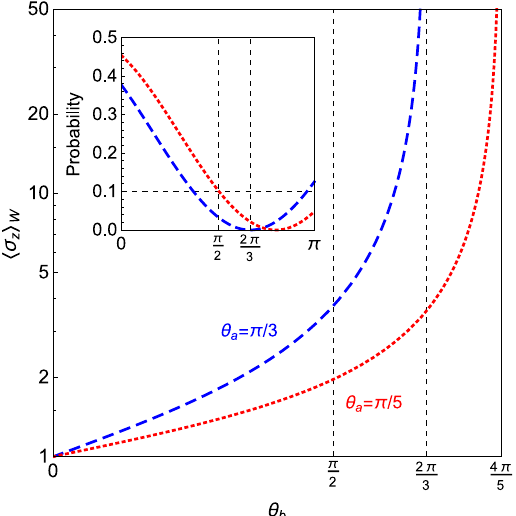
Figure 2. The weak value amplification for a Bell state, i.e. Eq. (7), managed by the projections of the target qubit a , and control qubit b , with a given probability (Inset). Here δ ≡ φ a + φ b = π and σ → ∞ .